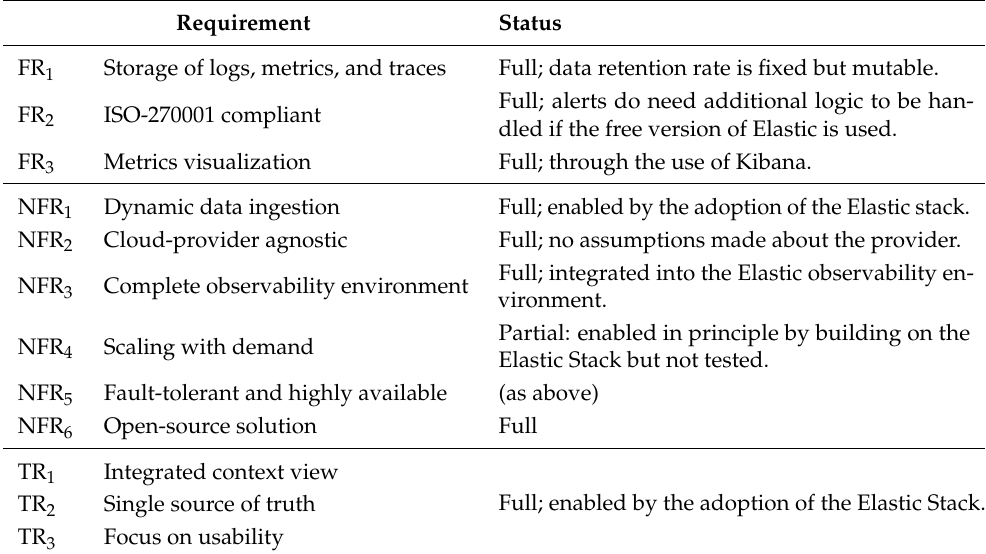
Table 4. Status of the elicited requirements for the case as summarized in Table